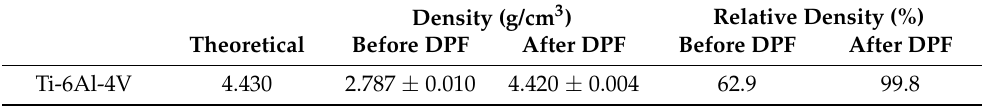
Table 2. Average titanium samples density before and after DPF.